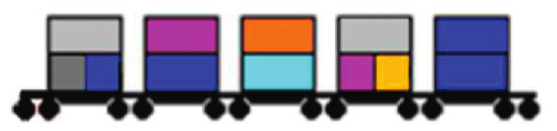
Figure 1: Three-stage solution framework.